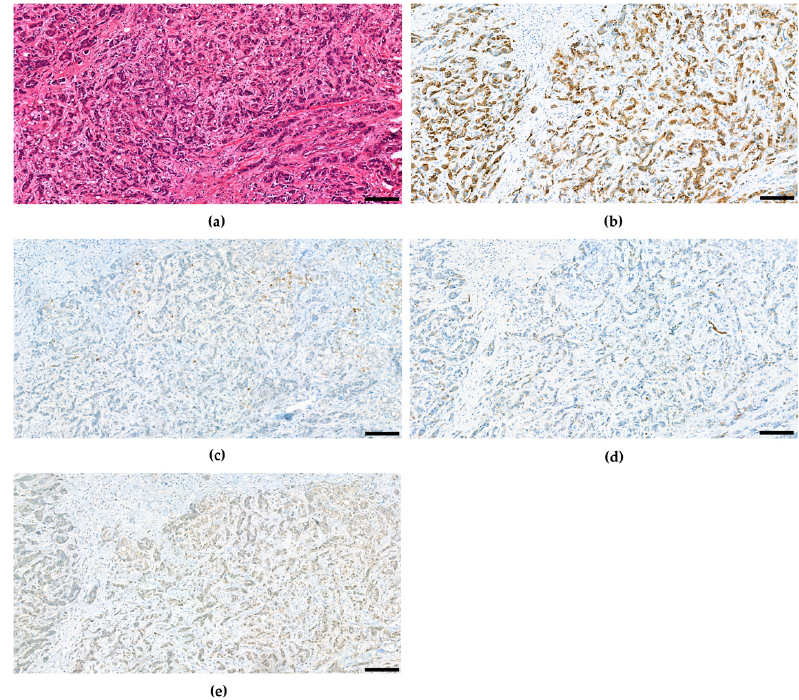
Figure 4. Combined hepatocellular and cholangiocellular carcinoma, intermediate cell component. CD56 and c-Kit were not expressed (not shown). ( a ) H&E. ( b ) CK7. ( c ) HepPar1. ( d ) CK19. ( e ) Arginase-1. Scale bar: 100 µm.